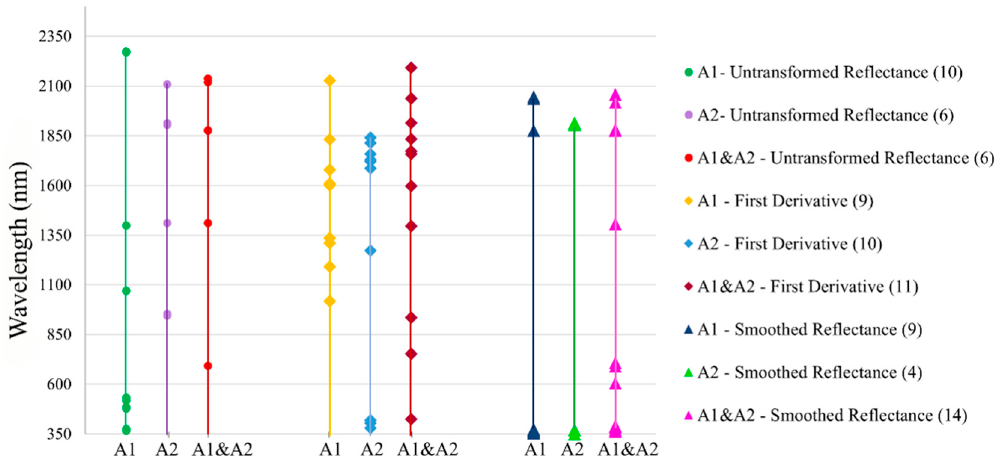
Figure 12. Locations of selected spectral variables for the three sample sets and spectral treatments under analysis.